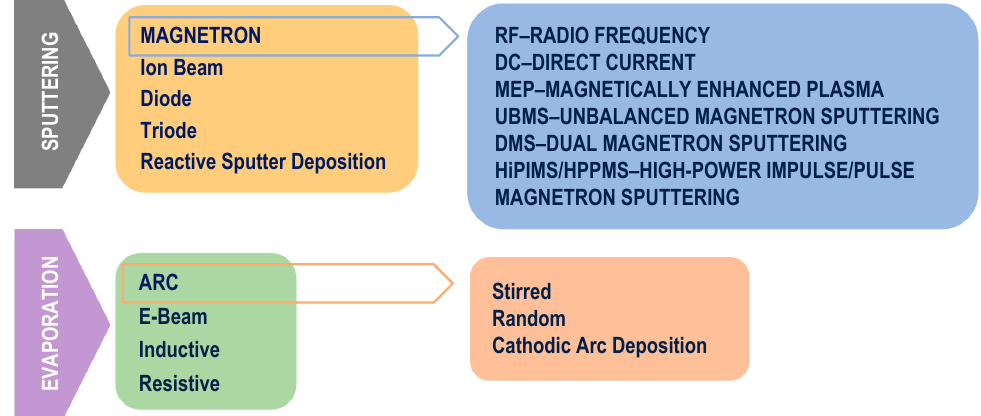
Figure 1. Segmentation of the current physical vapour deposition (PVD) techniques for advanced coatings.